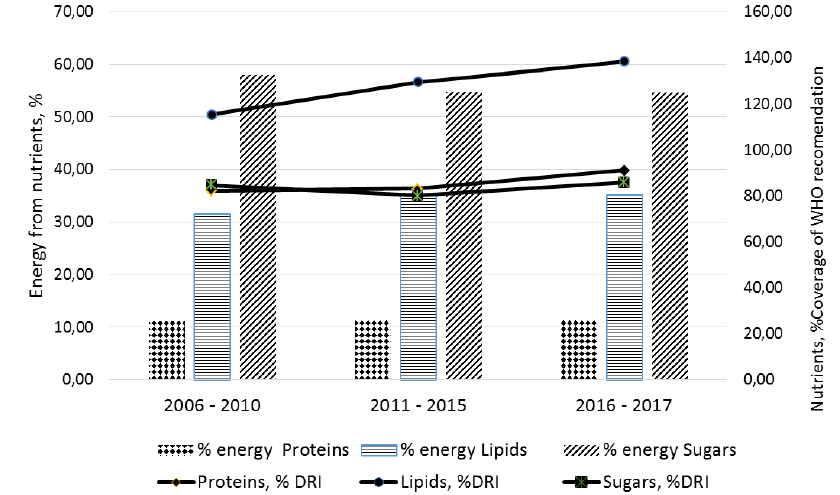
Figure 2. Average nutritional intake in the Republic of Moldova contained